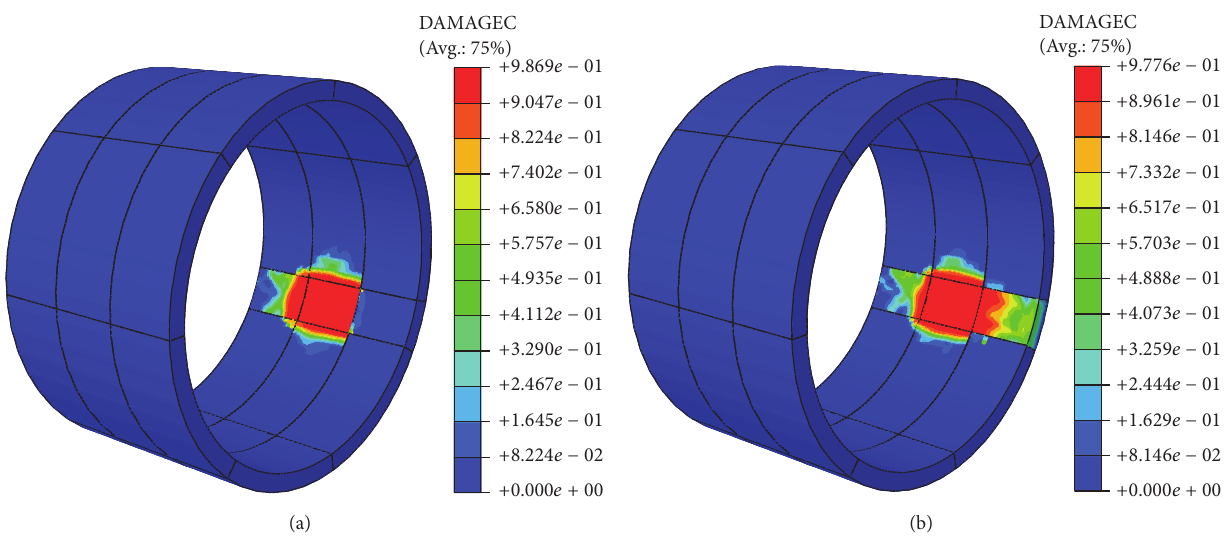
Figure 17: Compressive damage contours of the lining intrados in (a) Model I and (b) Model II.